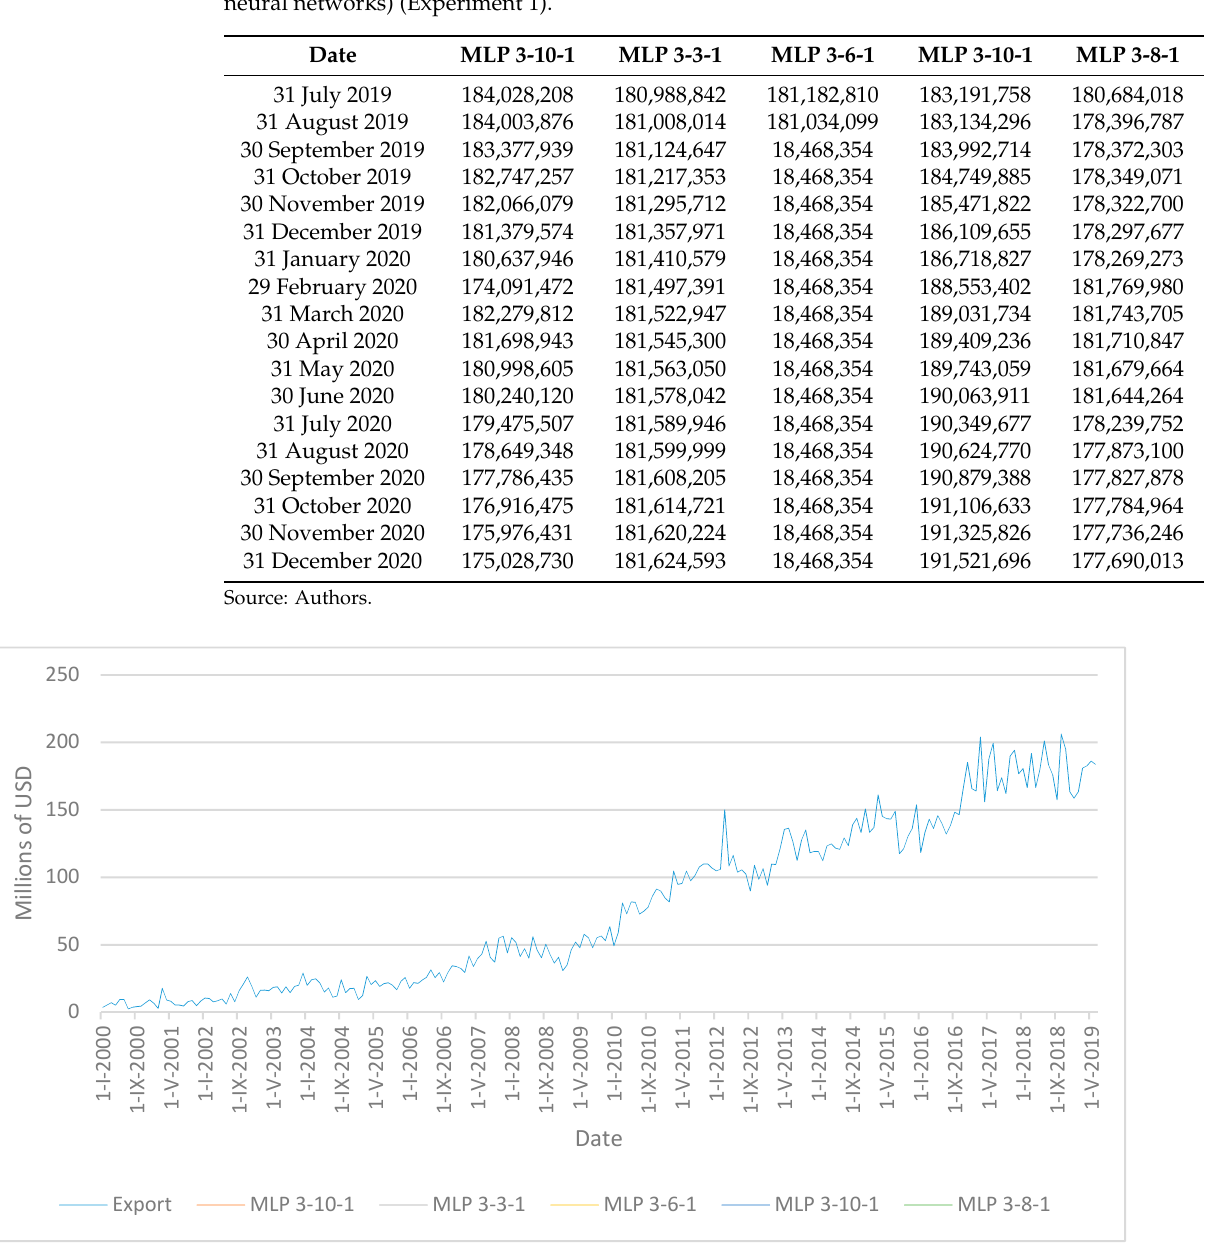
Figure 3. Time series and predicted development of exports according to retained networks (Experiment 1). Source: Au- thors.